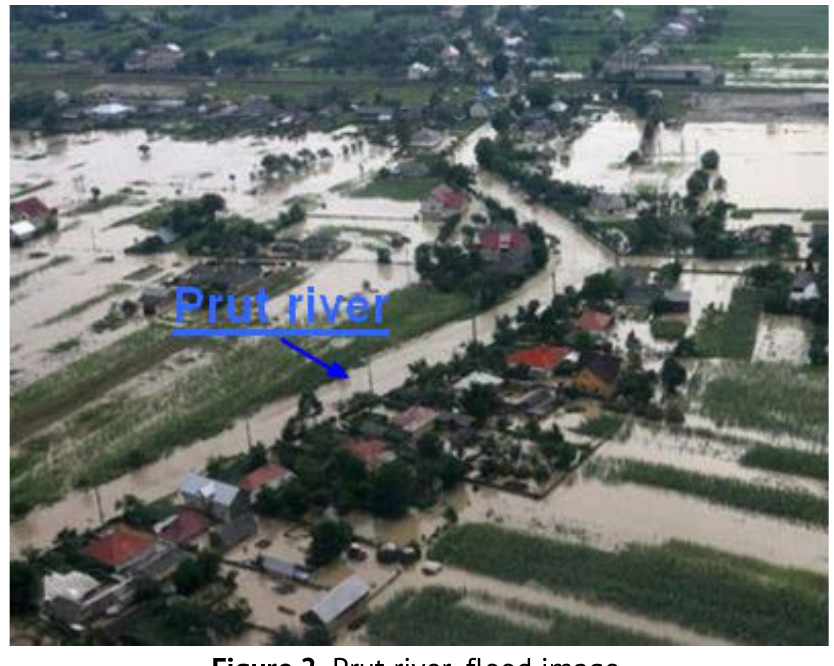
Figure 2. Prut river, flood